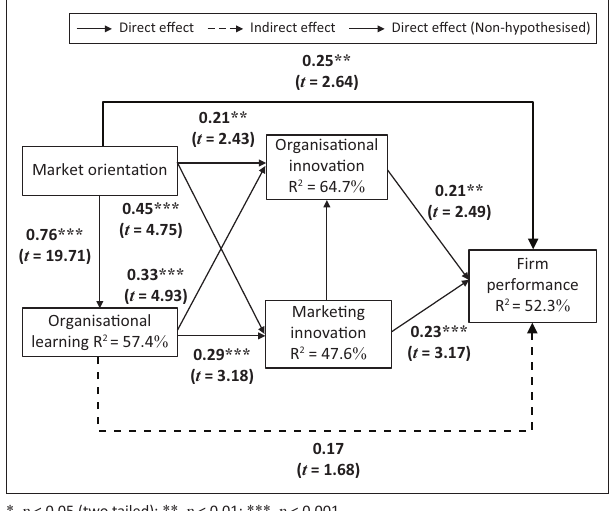
FIGURE 3: Structural equation model of non-technical innovation, market orientation and organisational learning with managerial performance in small- size project-based service firms.